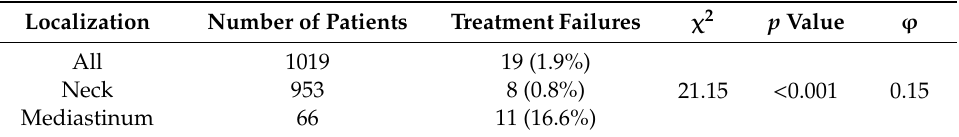
Table 4. Treatment failures.